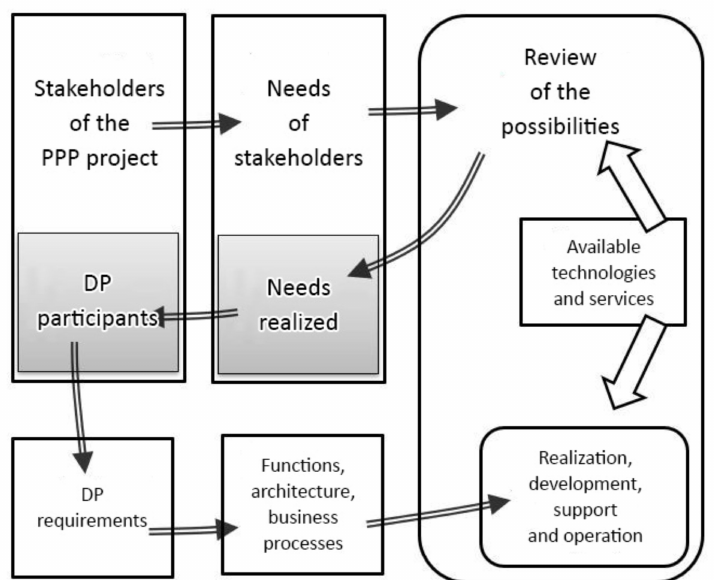
Figure 1. Digital platform development